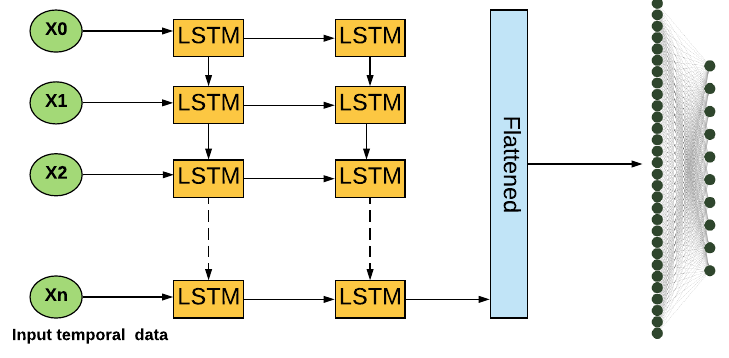
Figure 2. Architecture of the LSTM model for human activity recognition.